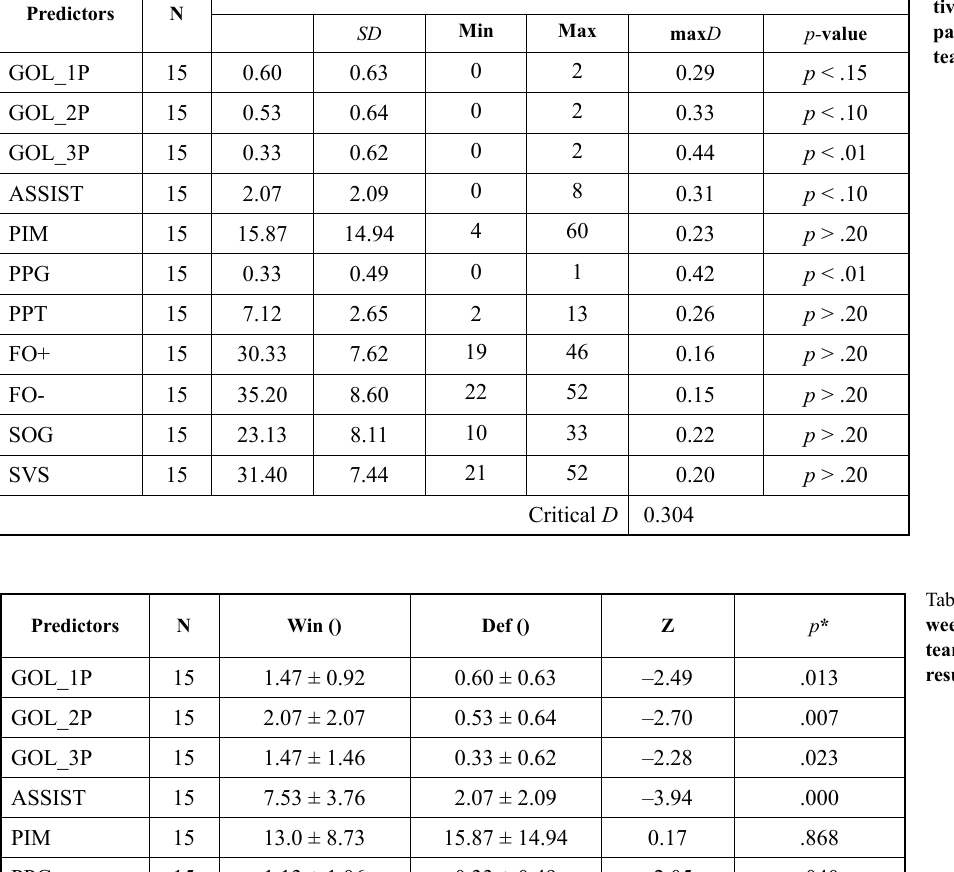
Table 3. Basic descrip- tive situational efficiency parameters of defeated teams